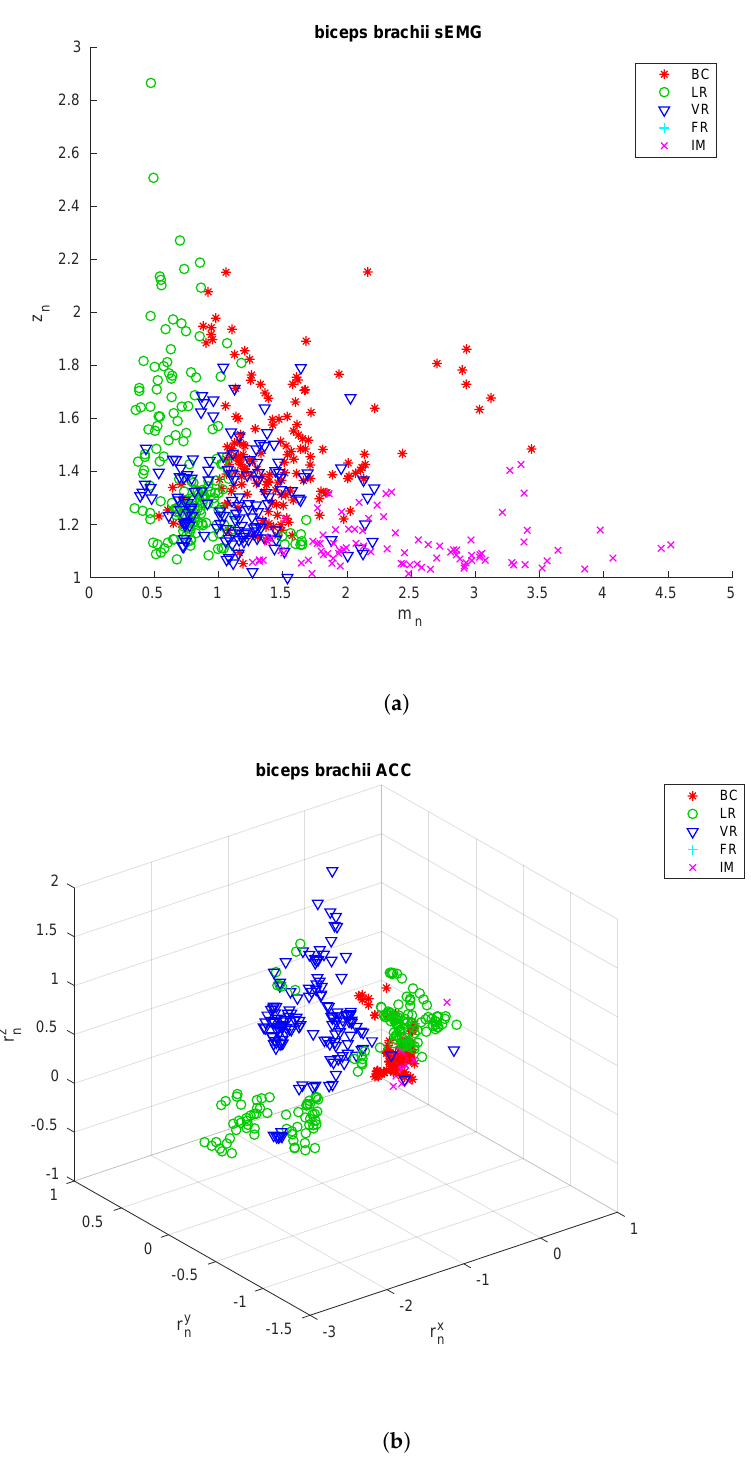
Figure 3. Biceps brachii features. Extracted from the sEMG signal ( a ) and the acceleration signals ( b ) from the sensors applied to the biceps brachii of all the subjects included in the training and testing